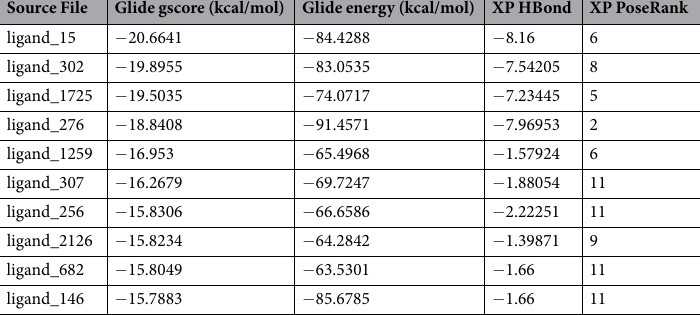
Table 2. Glide scores of the best 10 docked ligands.